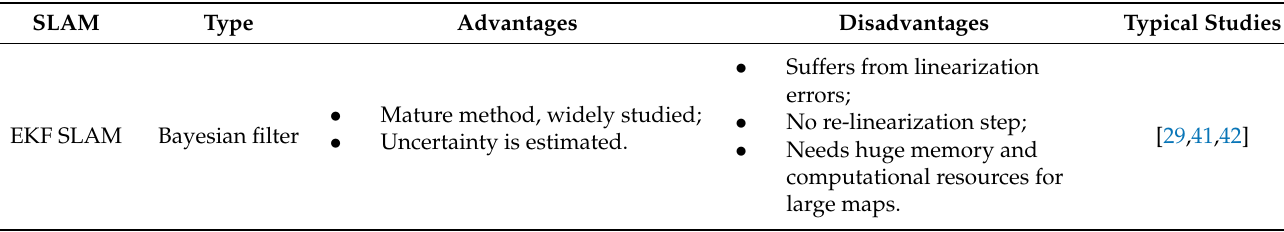
Table 1. Characteristics of some typical SLAM